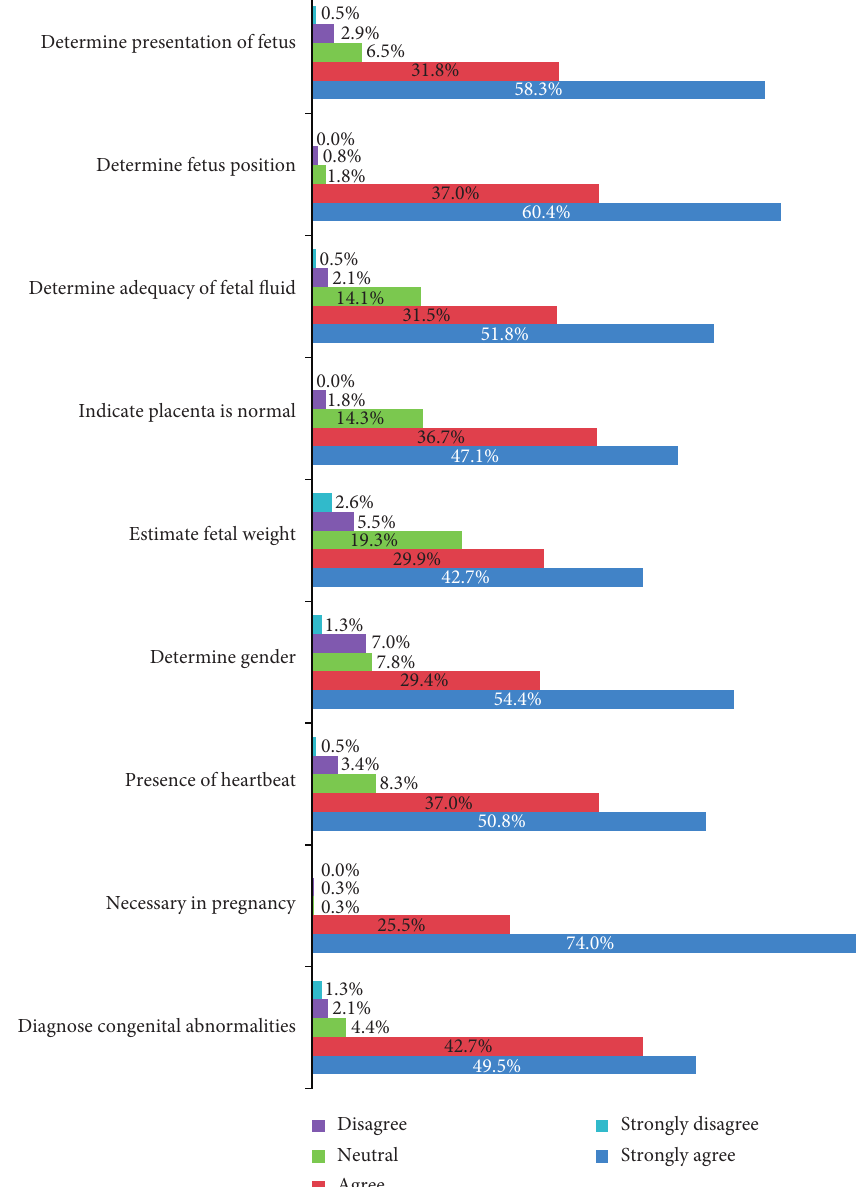
Figure 2: Knowledge of respondents about the ultrasound